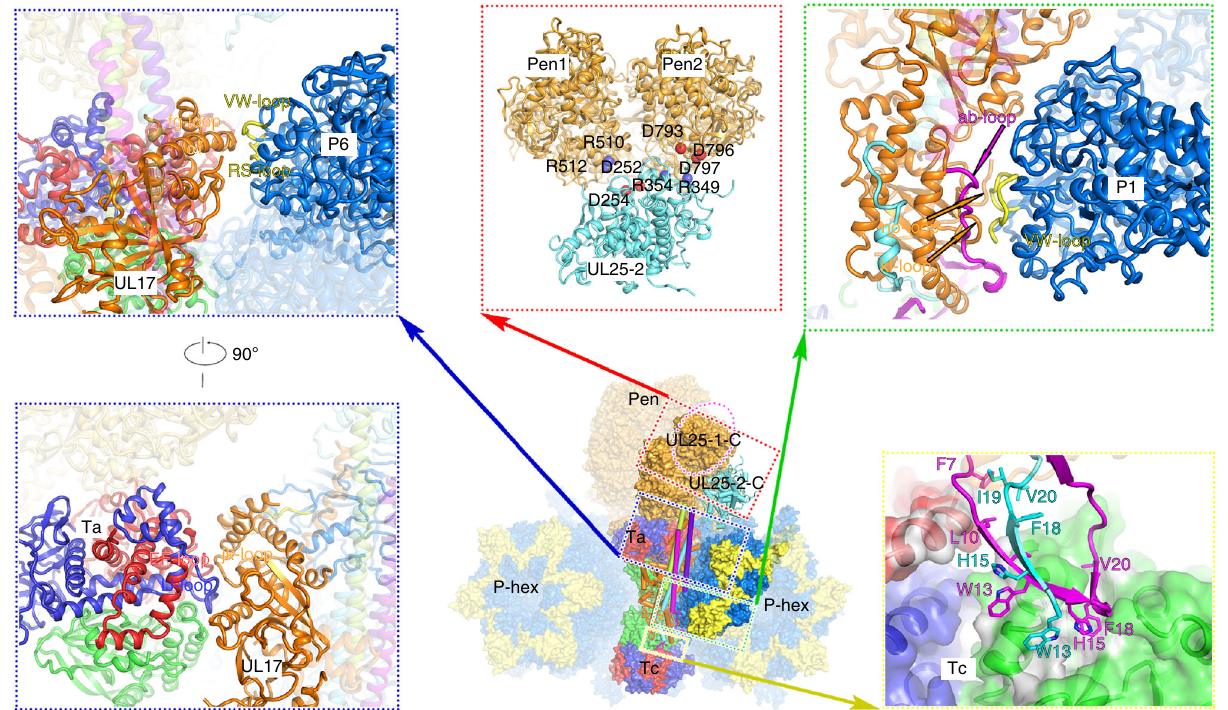
Fig. 4 Interactions between CVSC and surrounding capsid proteins. The CVSC is shown as cartoon and the remaining structure is rendered as a surface. Capsid proteins contacting the CVSC are highlighted in bright colors and labeled. Model of the UL25-2: Pen – VP5 interface (red inset) highlighting the charge interactions. Interactions between the Ta-binding region of the CVSC and the Ta, P-Hex (blue inset). To show the Ta-binding region clearly, the stalk region is set with 70% transparency. The green and yellow insets show the contacts between the distal region and the Tc, P ’ -Hex. The color scheme is the same as that of Fig. 1c. The loops in P1 and P6 involved in binding to the CVSC are highlighted in yellow. The N-extensions of two UL25 conformers insert into two cavities of Tc triplex via hydrophobic interactions. Hydrophobic residues from two UL25 conformers and Tc triplex are shown as sticks and presented as gray surface,